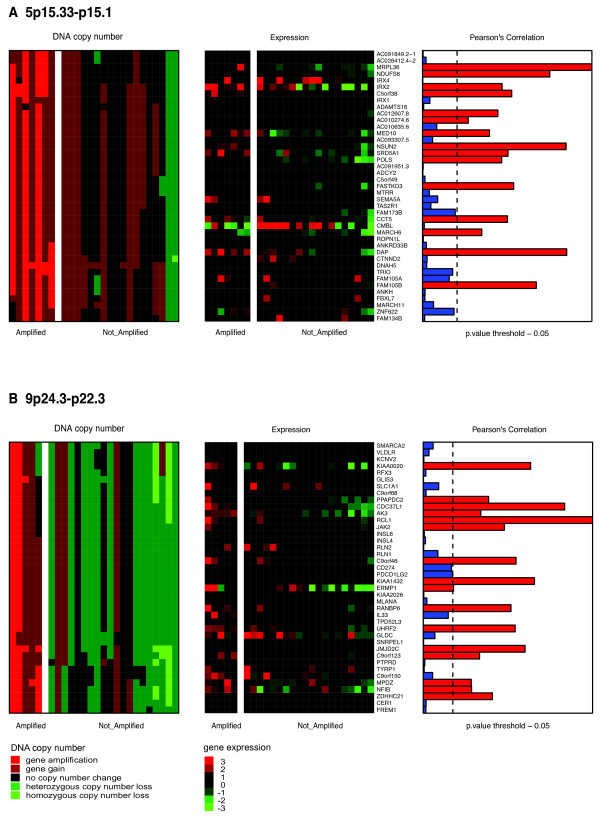
BC cell lines recapitulate recurrent triple-negative BC-specific amplicons and their possible drivers. Matched heatmaps of gene expression and aCGH within regions of recurrent amplification in BC cell lines (A) and (B). Cell lines were split into those with amplification (AMP) and those without (NA). Heatmap of aCGH (left) shows amplification in red, deletion in green and no change in black for each corresponding chromosomal location of the respective gene. Expression heatmap (middle) indicates if expression values for the gene are above (red) or below (green) the median value. Barplots (right) illustrate of a Pearson’s correlation analysis between expression and DNA copy number levels. Black dotted lines show adjusted P_value threshold of 0.05.